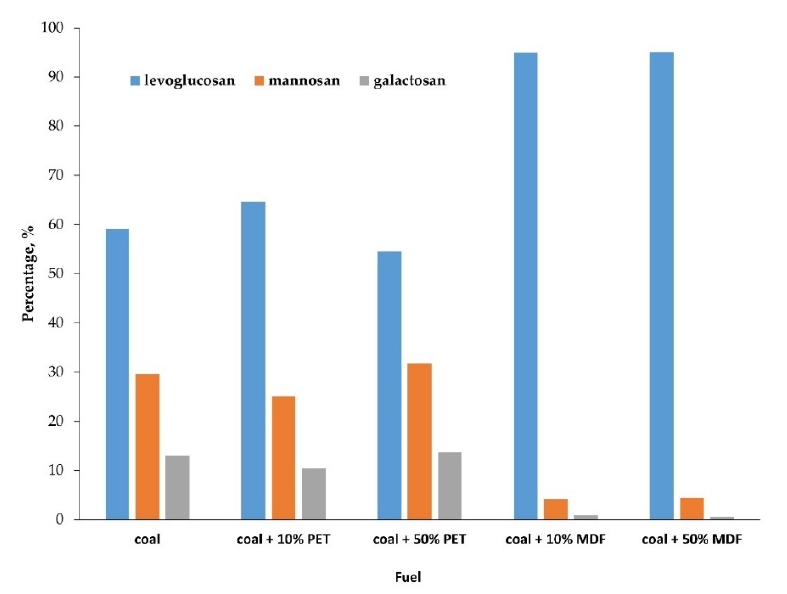
Figure 6. Percentage of individual monosaccharides in total emission of monosaccharides.